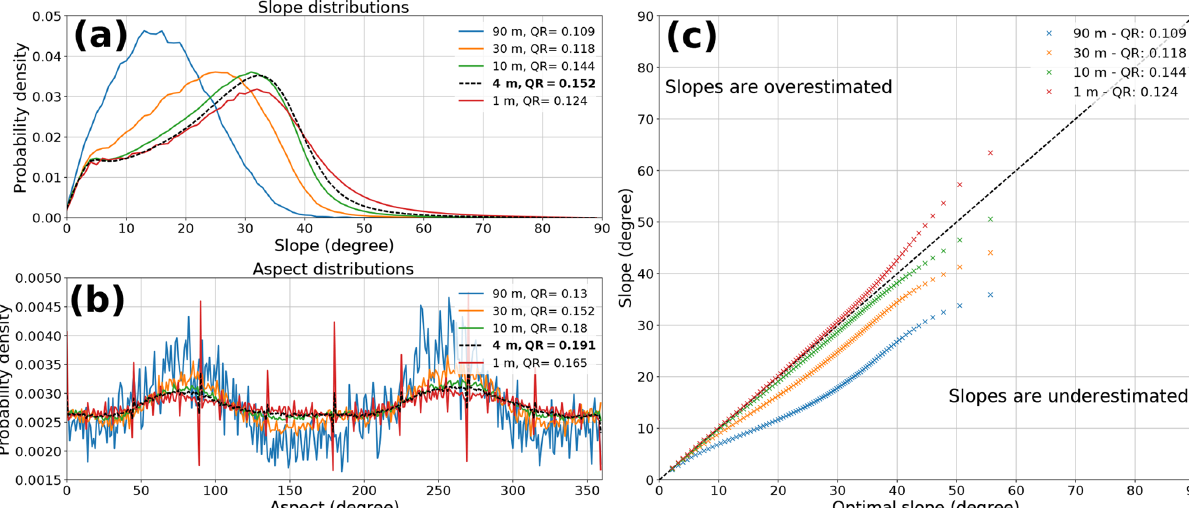
Figure 13. (a) Slope and (b) aspect differences across SCI DEMs, with QR calculated using SCI DEM elevation standard deviations (see Figs. 10 and S22–S24). Optimal slope and aspect distributions are plotted in black. (c) Quantile–quantile plot showing difference between the entire SCI slope distribution vs. the “optimal” (4m) resolution. We observe a clear pattern in slope distributions where resolutions below the optimal resolution tend to overestimate slope, and those below tend to underestimate slope.